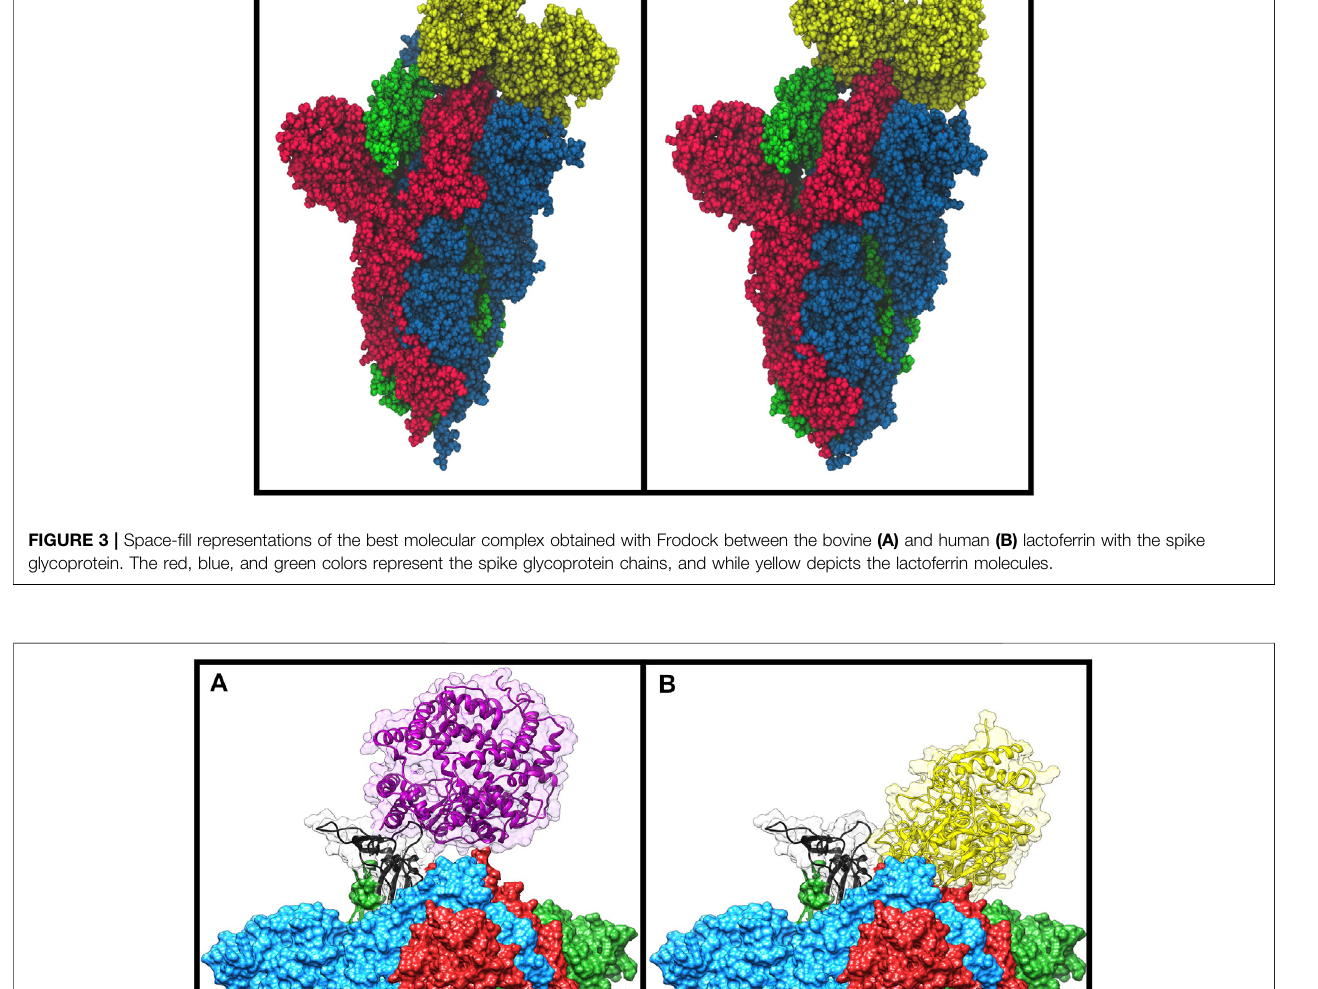
Frontiers in Pharmacology |